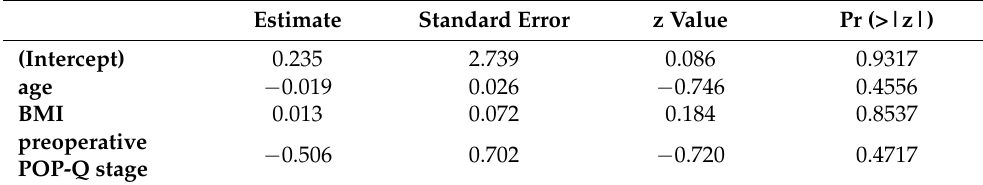
Table 5. Logistic regression. Postoperative complications in the study group (SSH): age, BMI, preoperative POP-Q stage. p = 0.7821; residual deviances: 64.648 for the null model vs. for the full 63.343